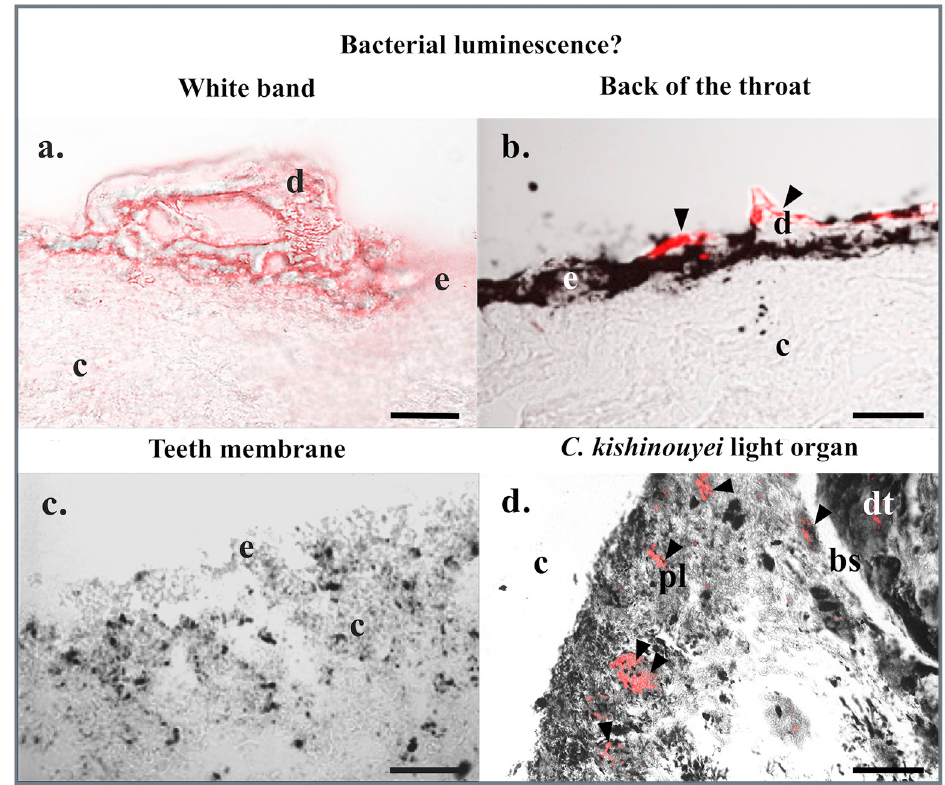
Fig 3. Fluorescence in situ hybridization: Bacterial luminescence? Fluorescence in situ hybridization on (a) white band, (b) back of the throat, and (c) teeth membrane skin sections of M . pelagios as well as (d) C . kishinouyei light organ sections using EUB RNA probes. Black arrowheads indicate bacteria-labeled areas. bs, basal layer of the digestive tract-related tubules; c, connective tissue; d, dermal denticle; dt, digestive tract tubule; e, epidermis; pl, pigmented layer. Scale bars: 100 μ